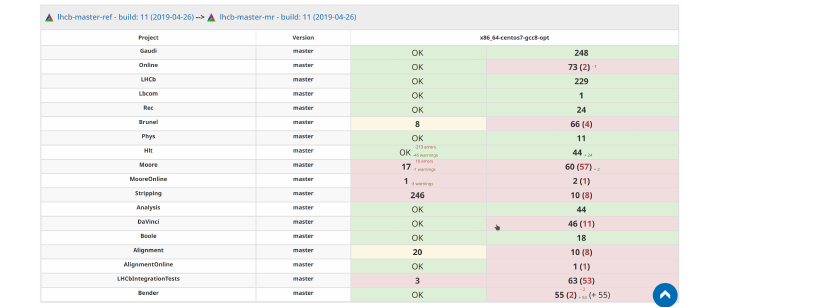
Figure 4. An example of feedback to a developer who has requested a test build to be performed on a given MR. Red on the right column indicates changes in the test results of high level tests across di ff erent projects. These changes should be understood by a project maintainer before a MR is merged. Numbers in this table indicate how many tests have passed (in bold) or failed (in brackets) after building the head of a MR and running the nightly tests. ’OK’ (green background) indicates that the tests run against this MR are the same as when they were run on the Ref branch. The change in number of tests failing due to isolated changes within an MR are summarised with additional numbers in this table (red and yellow